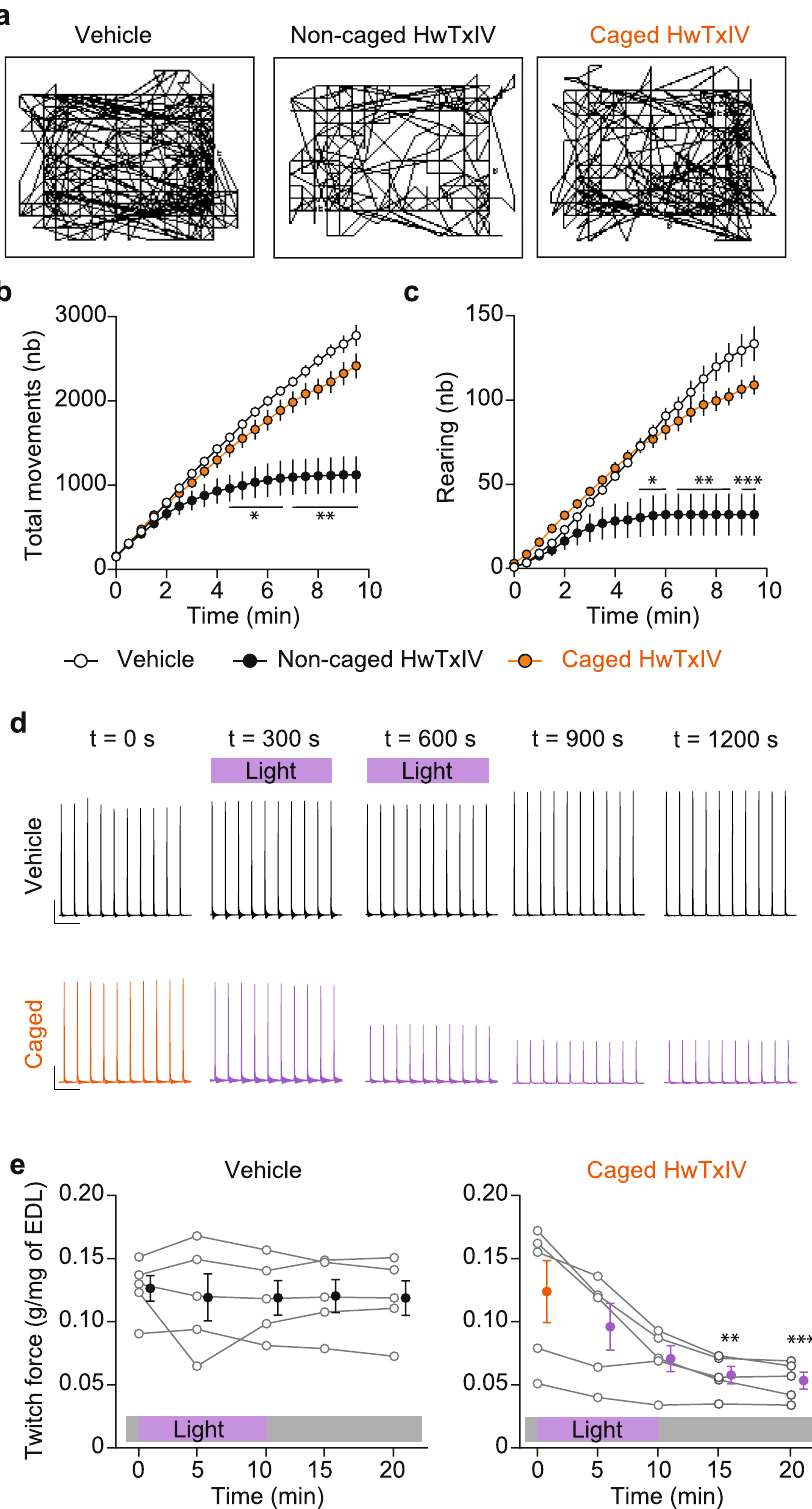
Fig. 6 In vivo uncaging of HwTxIV-Nvoc. a Representative trajectory plots of mice injected with vehicle (left), non-caged HwTxIV (center) or HwTxIV- Nvoc (right). b – c Quanti fi cation of total movements ( b ) and rearing ( c ) in mice injected with vehicle (white circles), HwTxIV (black circles) or HwTxIV- Nvoc (orange circles). ( n = 5 in each group, mean ± SEM * p < 0.05; ** p < 0.01; *** p < 0.001 versus vehicle, two-sided repeated-measures 2-way ANOVA test followed by Tukey ’ s post test). d Representative twitches obtained from mice injected with vehicle or HwTxIV-Nvoc at t = 0; t = 5; t = 10; t = 15; t = 20 min after injection. e EDL twitch force normalized to muscle mass (g/mg of EDL) in vehicle or HwTxIV-Nvoc mice before and after illumination (365 nm, 50 mW/cm 2 ). ( n = 5 in each group, mean ± SEM ** p = 0.0041; *** p = 0.0002 versus t0, two-sided repeated-measures Friedman test followed by Dunn ’ s post-test). Source data are provided as a Source Data File.